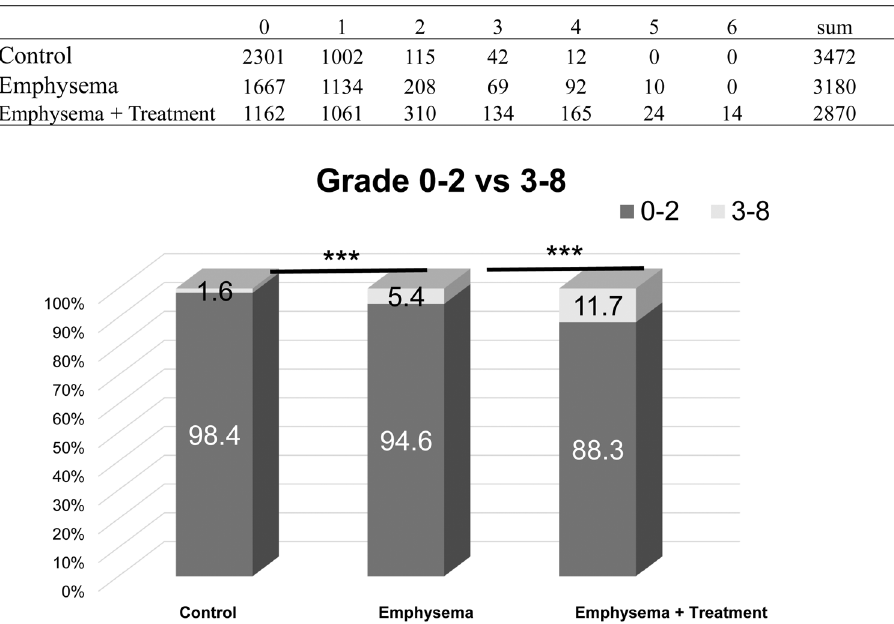
Figure 6. Fibrosis assessment by using the modified Ashcroft scoring. The breakdown of the total 1 mm × 1 mm squares of the specimen are shown in the upper table. The lower graph shows that the emphysema + treatment group had a significantly higher distribution of clear-cut fibrosis (Grade 3 ≧ ) compared to the emphysema group. Asterisks above the horizontal lines indicate a significant difference in the comparisons between the groups ***p < 0.001).